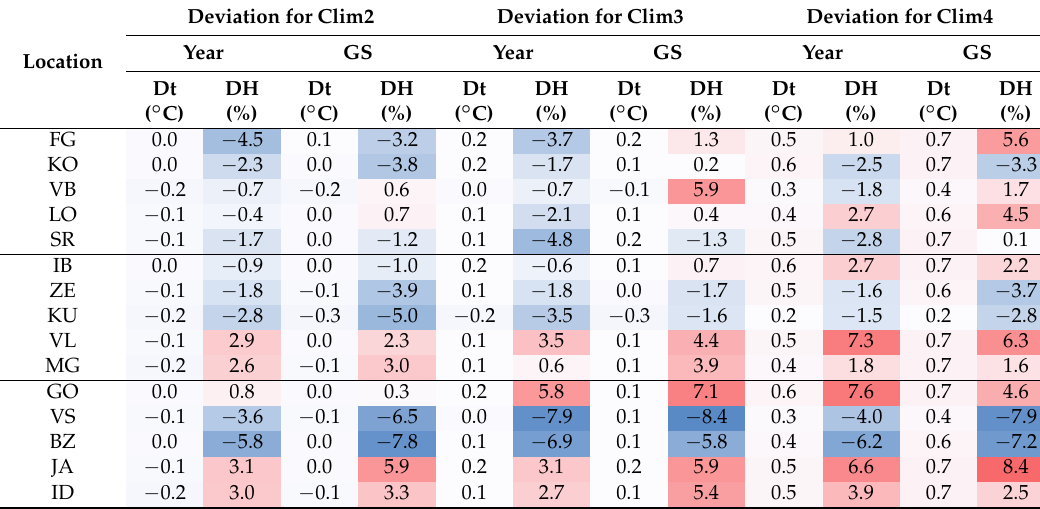
Table 2. Deviation of temperature (Dt) and precipitation (DH) for selected climatological periods in respect to 1951–1980 reference climatology (GS—growing season).